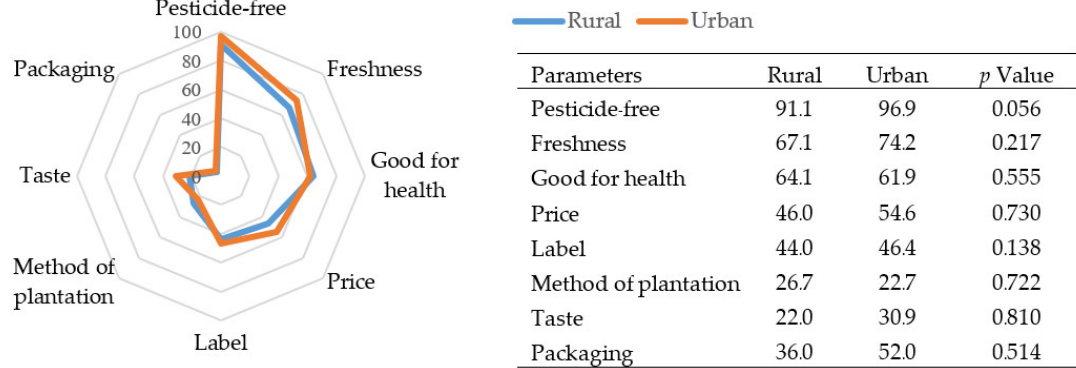
Figure 1. Percentage (%) of considerations for purchasing VF.